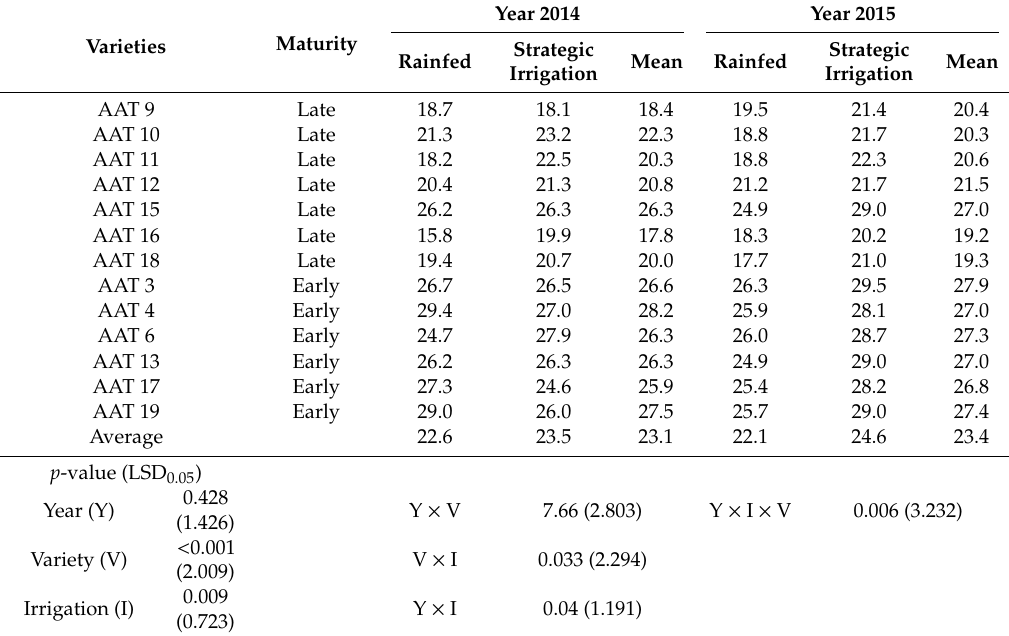
Table 6. Varietal 1000 grain weight (g) under strategic irrigation and rainfed conditions in Alton Downs, 2014 and 2015.